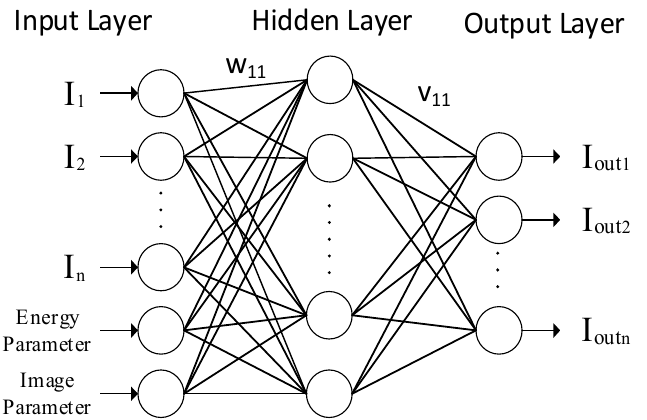
Figure 3. Schematic diagram of the structural model of the KPBP method’s backpropagation neural network. I 1 to I n represent the intensities in SPEC and I out1 to I outn represent the intensities of the standardized spectral fragment. The w and v represent the weight of each node in the network.